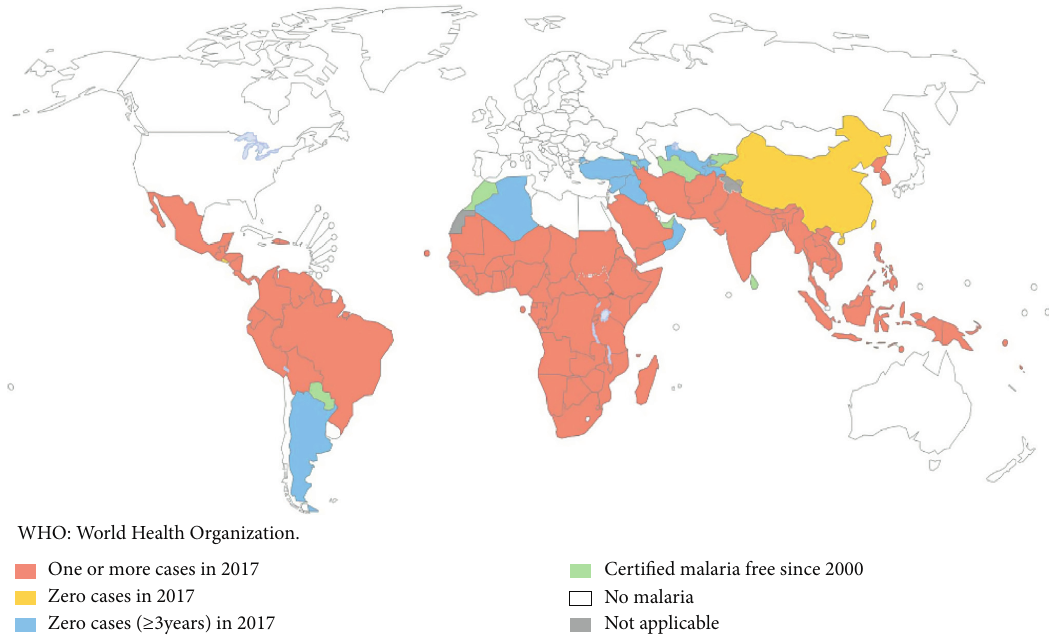
Figure 1: Global distribution of malaria throughout the world (source: World Malaria Report 2018) [1].